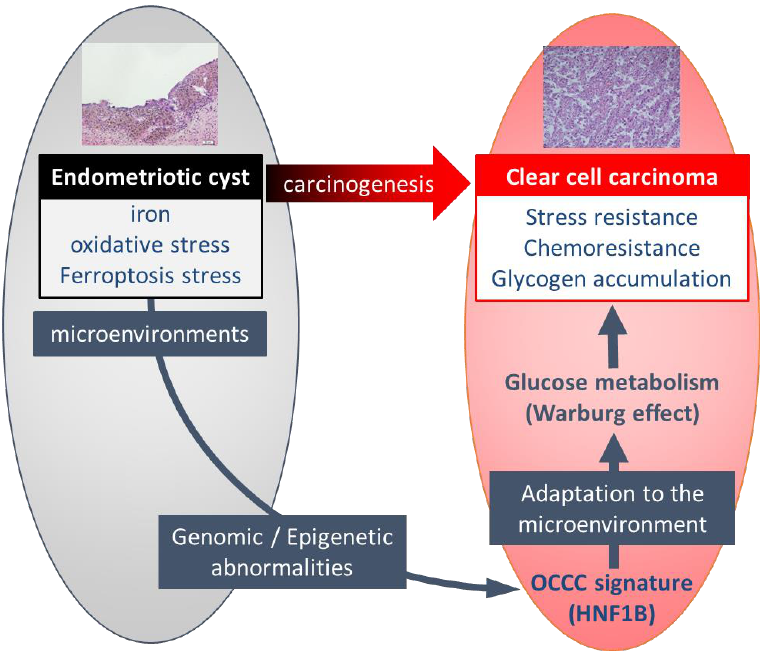
Figure 2. The schema of influence of the microenvironment of endometriotic cyst on the character- istics of ovarian clear cell carcinoma.